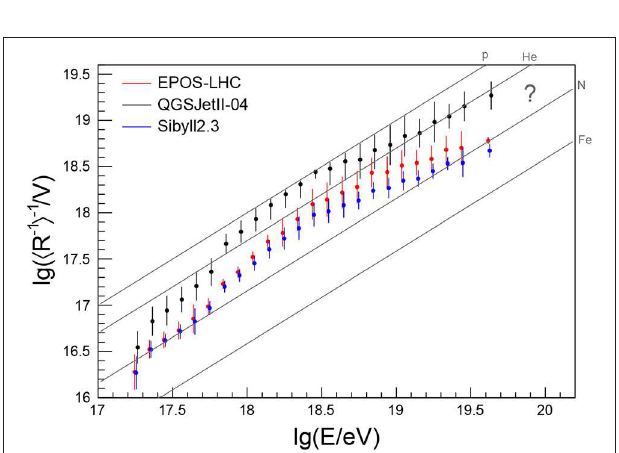
FIGURE 9 | Evolution of the UHECR rigidity with energy using the composition fractions estimated from Auger data in Bellido (2018) and Aab et al. (2014b) using air shower simulations with different hadronic interaction models. M. Unger for this